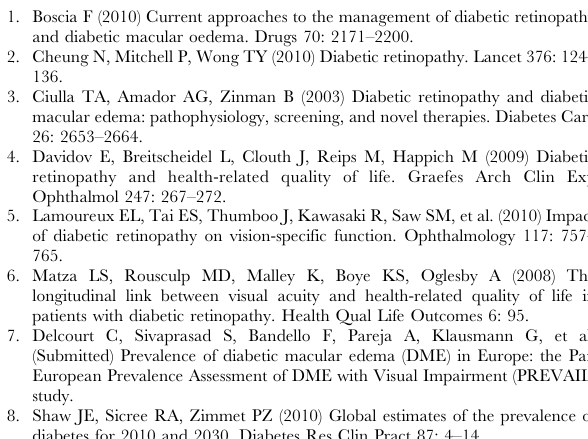
Table S5 Quality appraisal of included randomized controlled trials. Table S6 Summary of baseline BCVA (ETDRS letter score) in the study eye by study and treatment group. Table S7 Summary of baseline CRT/CFT in the study eye by study and treatment